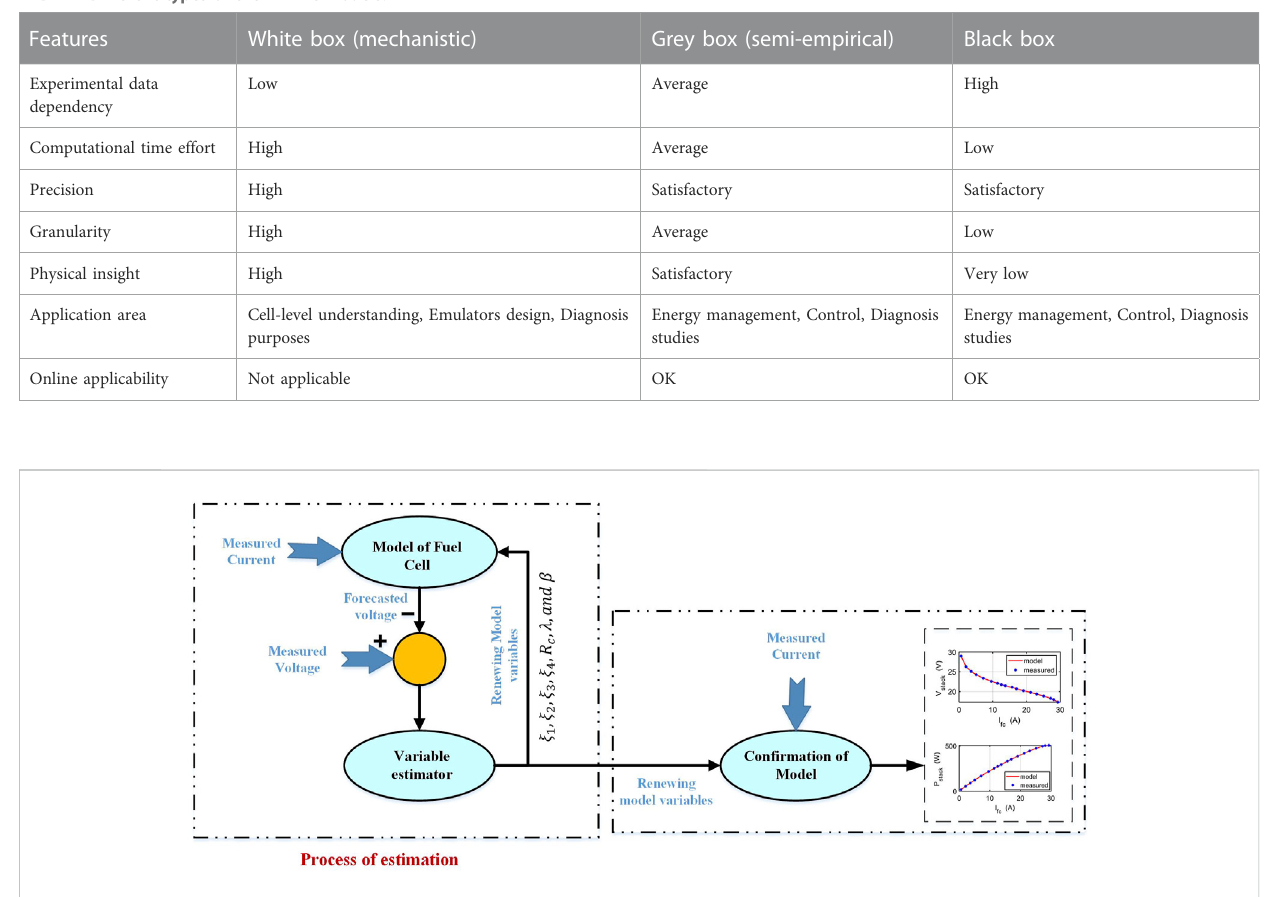
FIGURE 5 Basic modeling of the parameter estimation for a